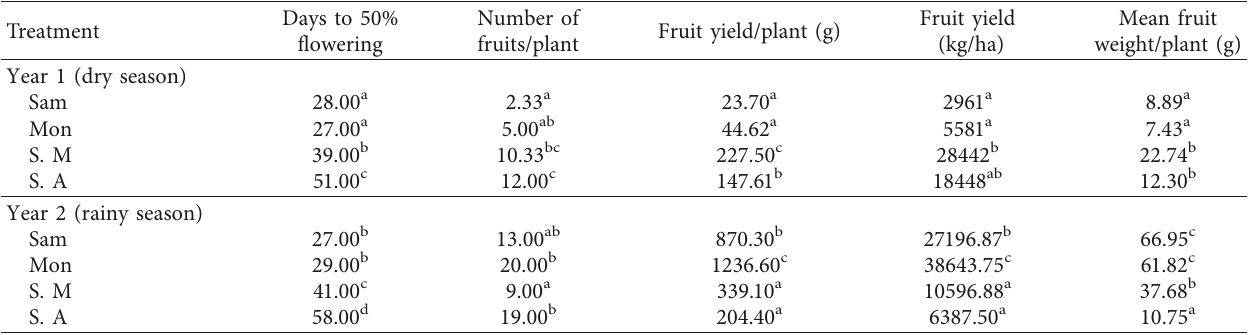
Table 4: Mean yield parameters of the rootstocks after RKN infestation in 2015 (year 1) and 2016 (year 2). Treatment